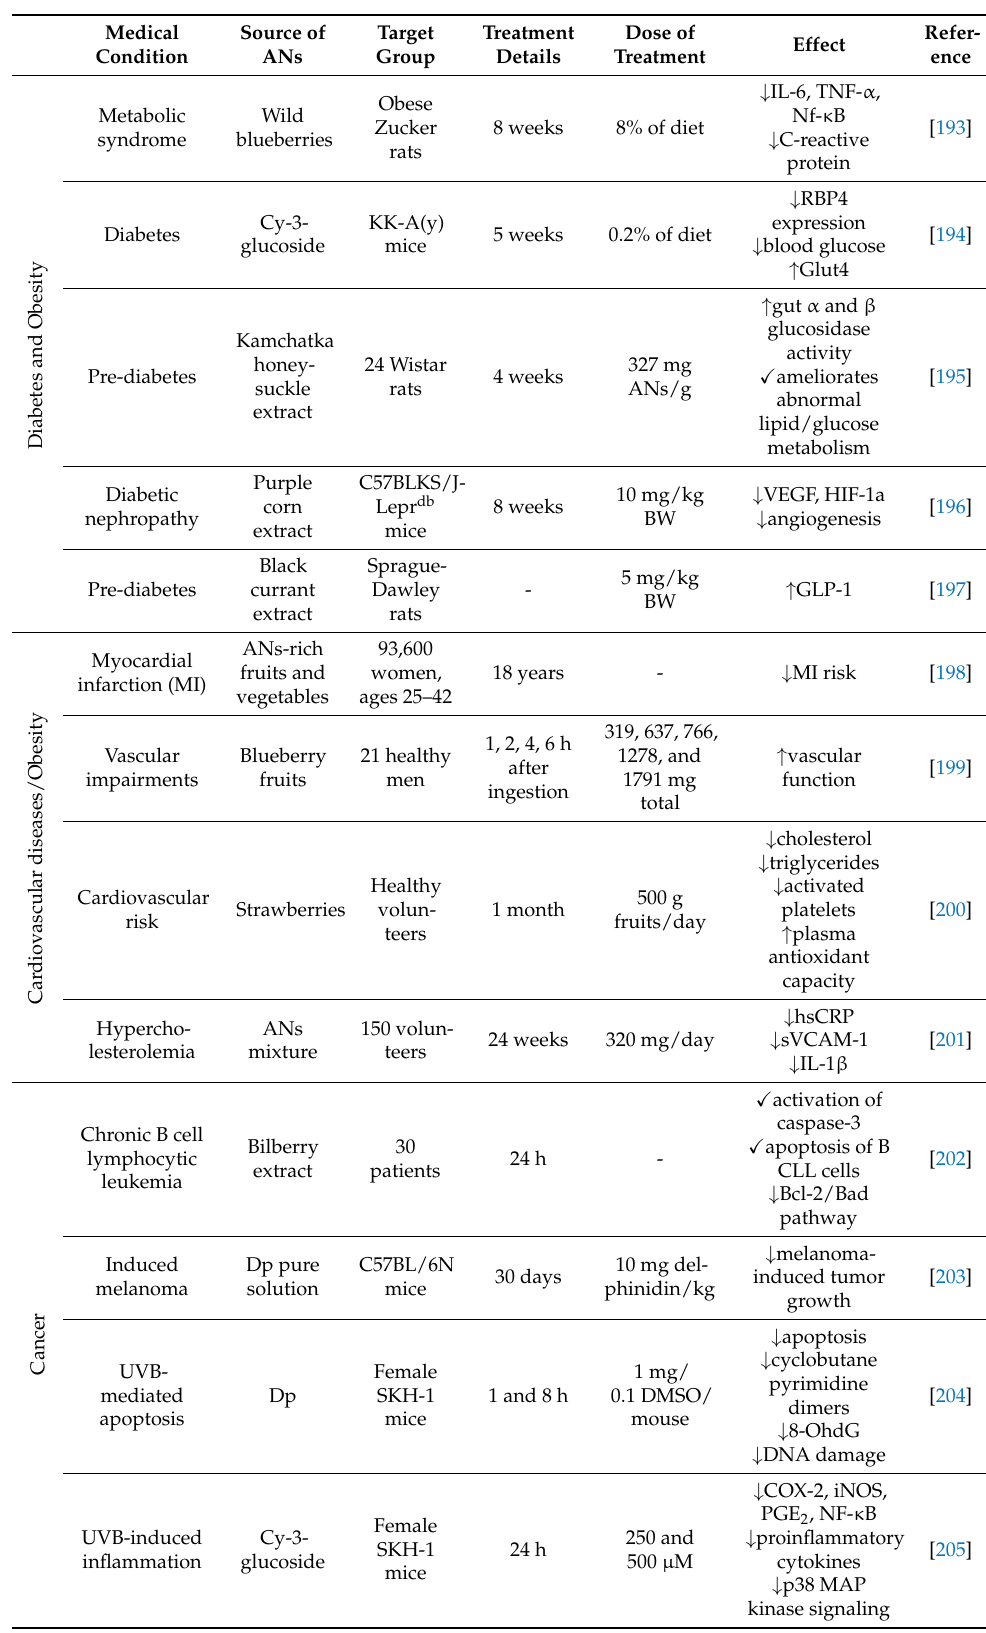
Table 2. Cont . Medical